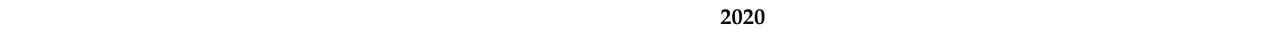
Table 37. Number of students enrolled in different levels of tertiary education in 2020, EUROSTAT.